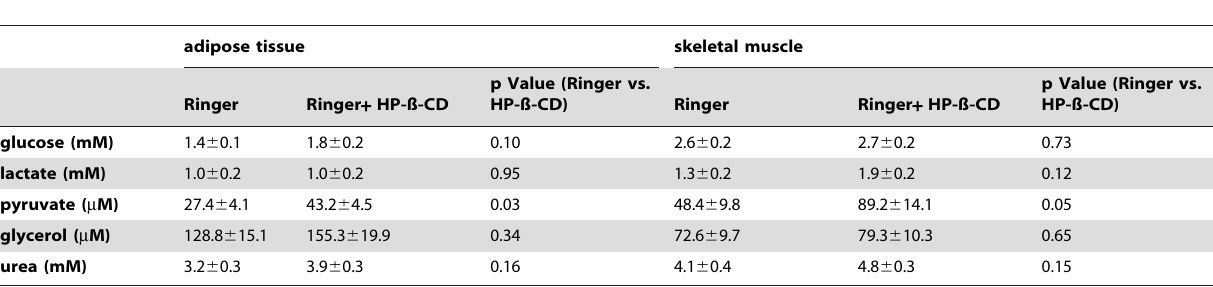
Table 2. In vivo microdialysis concentrations at 1 m l/min flow-rate (n= 12, mean 6 SEM).